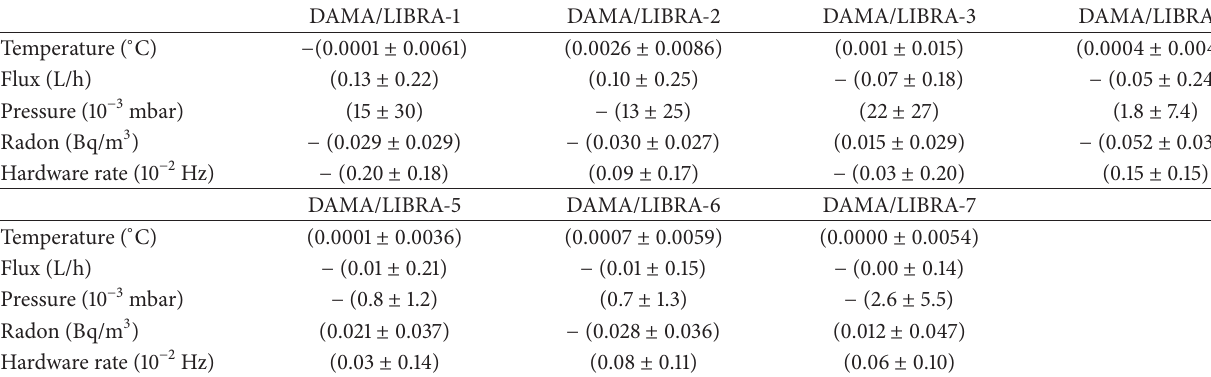
Table 2: Modulation amplitudes ( 1𝜎 error) obtained by fitting the time behaviours of the main running parameters including a possible annual modulation with phase and period as for DM particles. These running parameters, acquired with the production data are (i) the operating temperature of the detectors; (ii) the HP Nitrogen flux in the inner Cu box housing the detectors; (iii) the pressure of the HP Nitrogen atmosphere of the inner Cu box housing the detectors; (iv) the environmental Radon in the inner part of the barrack from which the detectors are, however, excluded; (v) the hardware rate above single photoelectron threshold. All the measured amplitudes are compatible with